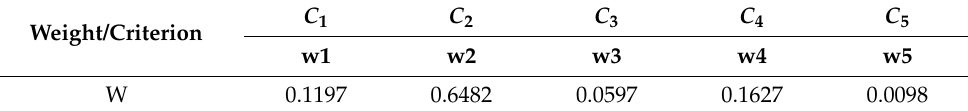
Table 11. By applying Shannon’s entropy method, the following weights of criteria were obtained.